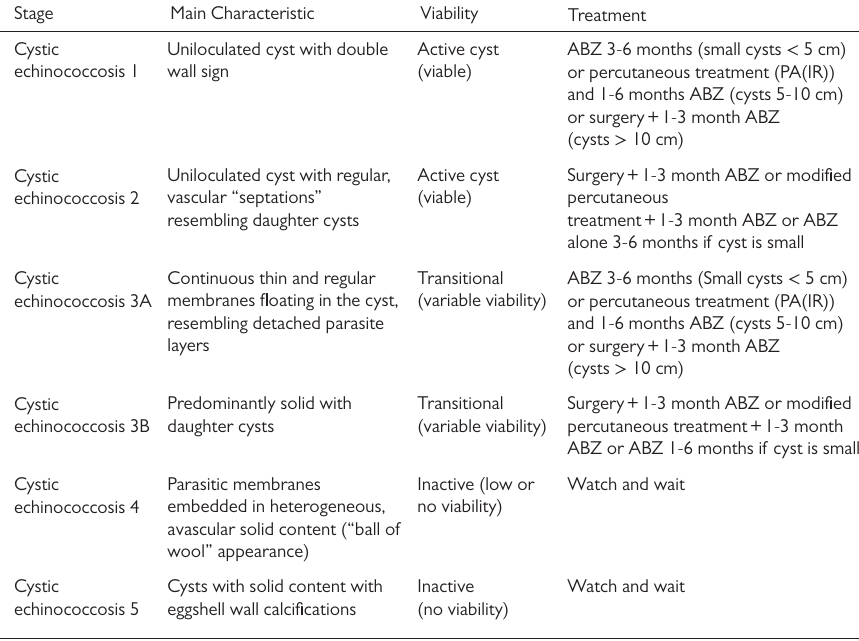
Table 1. WHO Classification of Cystic Echinococcosis and Recommended Treatments